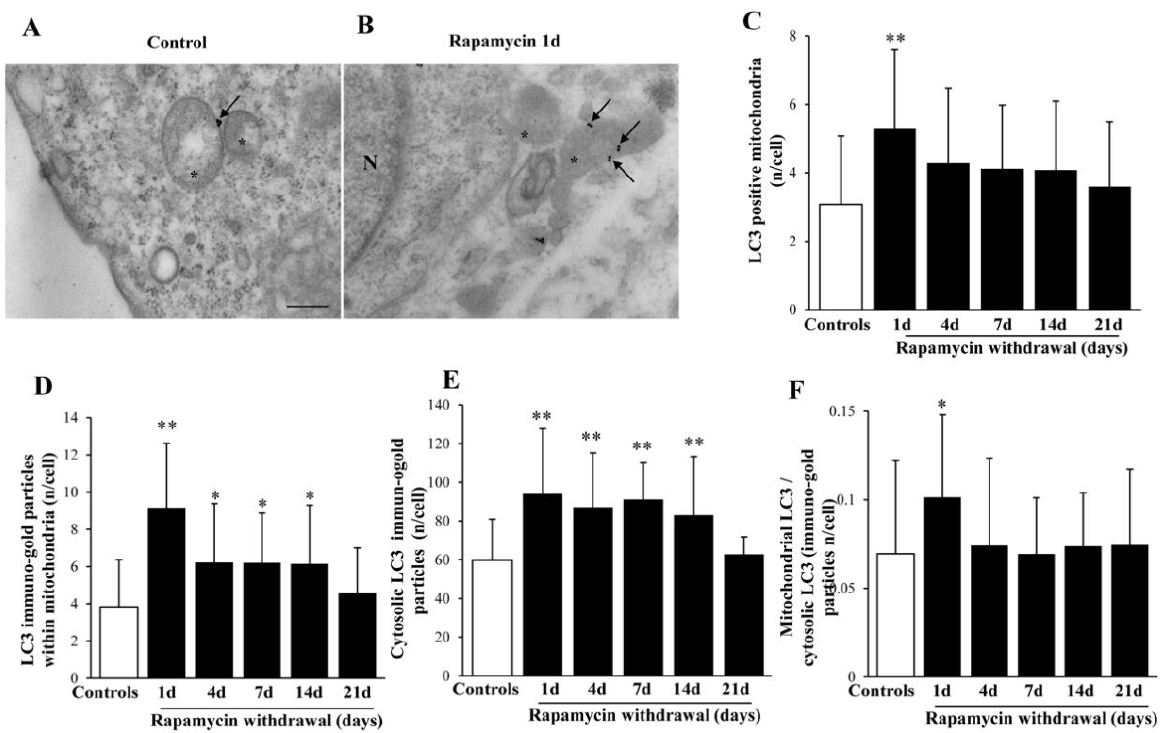
Figure 6. Rapamycin increases the amount of LC3-positive mitochondria. Representative TEM micrograph showing LC3-positive mitochondria from control ( A ) and following 1 d rapamycin withdrawal ( B ). Arrows point to LC3 immuno-gold particles within mitochondria. Graphs report the LC3-positive mitochondria ( C ), LC3 immuno-gold particles within mitochondria ( D ), the cytosolic amount of LC3 ( E ), and the ratio of mitochondrial to cytosolic LC3 particles ( F ). Counts represent the mean ± SD from N = 50 cells per group. * p ≤ 0.05 compared with control. ** p ≤ 0.05 compared with controls and 21 d. Scale Bar = 0.5 µ m, Asterisk (*) = mitochondria, N = nucleus.